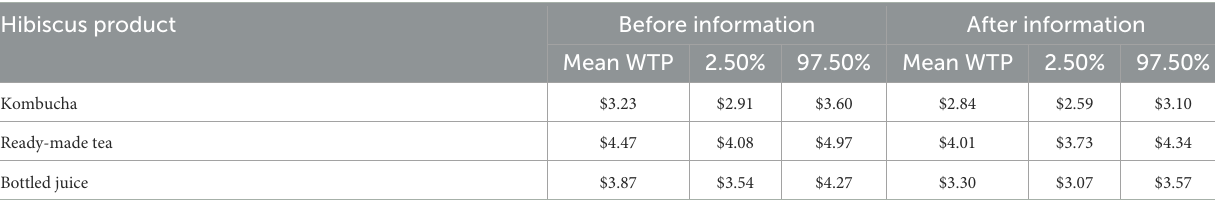
TABLE 5 Willingness-to-pay (WTP) for non-alcoholic hibiscus beverages pre- and post- health information provision ( n = 147). Hibiscus